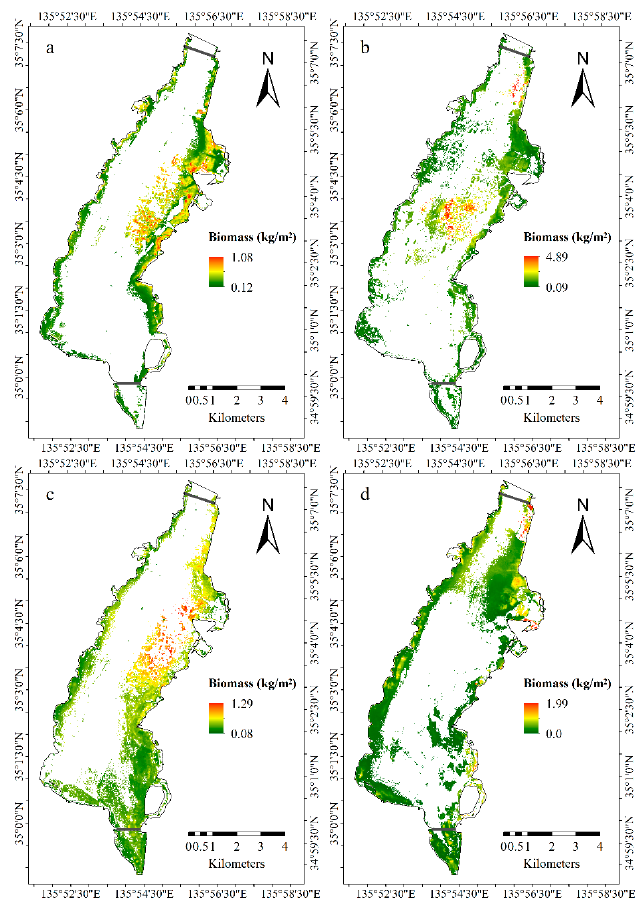
Figure 16. Satellite-derived biomass map (kg DW m − 2 ) of SAV and floating vegetation in the south basin of Lake Biwa (2013-2016): ( a ) October 2013, ( b ) September 2014, ( c ) September 2015, and ( d ) September 2016.